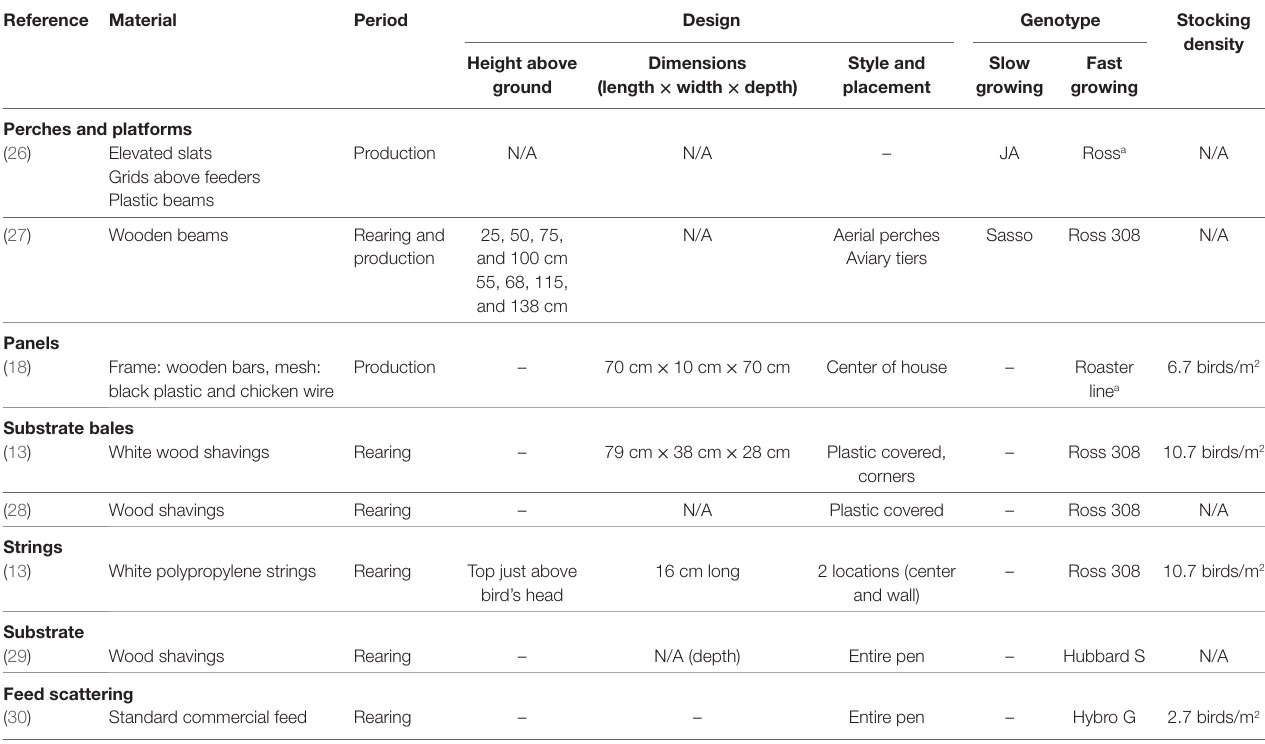
TABLe 1 | Perch, platform, panel, substrate bales, strings, substrate, and feed scattering designs for broiler breeders used in different